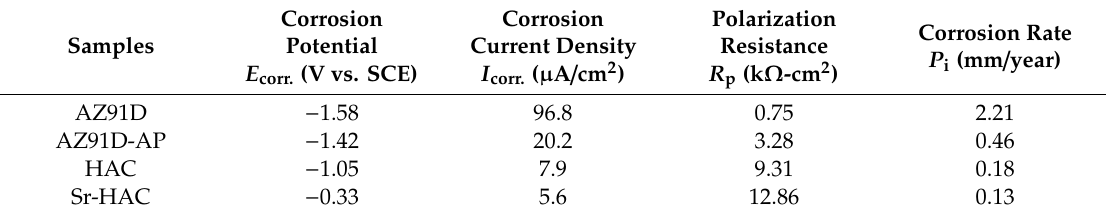
Table 2. Electrochemical parameters of grit-blasted AZ91D Mg alloy, alkaline pre-treated AZ91D-AP, hydrothermal HAC and Sr-HAC specimens in SBF at 37 ◦